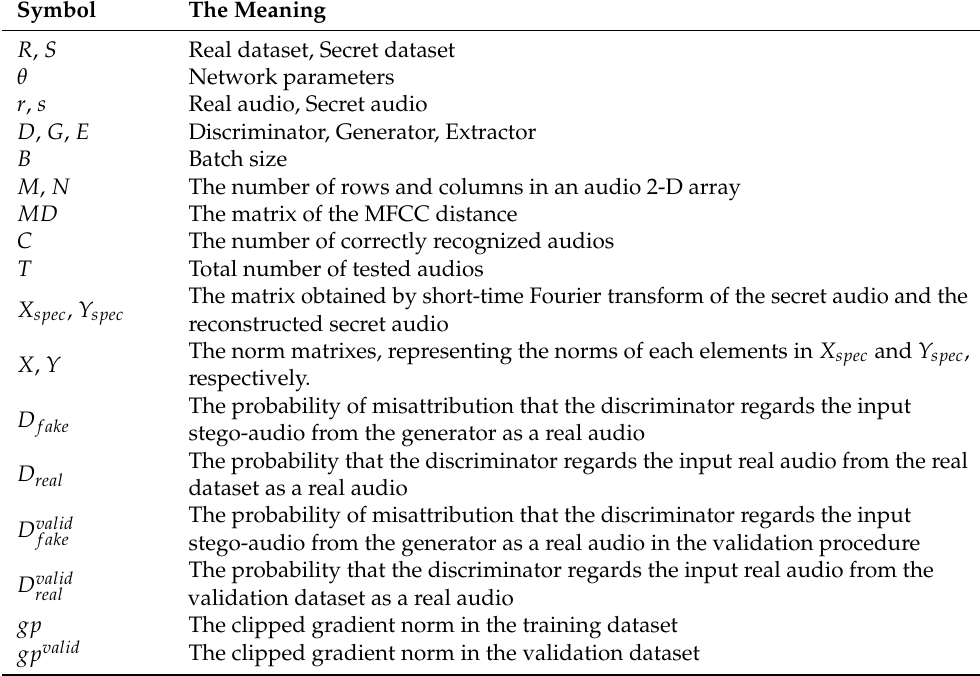
Table 2. The meanings of the main symbols used in this paper.